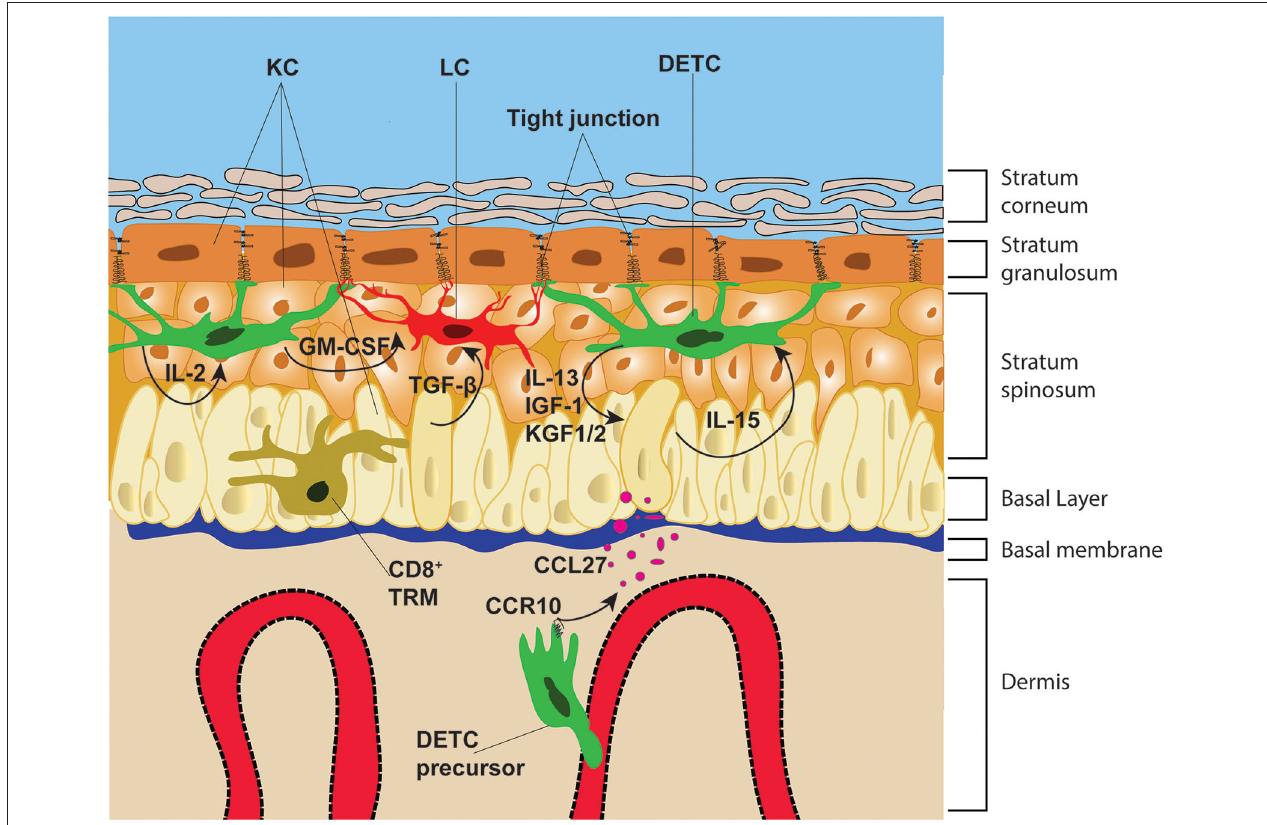
FIGURE 1 | Epithelial architecture and immune cell distribution. The epidermis is divided from the dermis by the basal membrane. The epidermis is composed of four distinct layers: the stratum corneum, stratum granulosum, stratum spinosum and basal layer. These layers are composed mainly of KC that are infiltrated with immune cells, such as DETC, LC, and CD8 + TRM. DETC precursors in neonatal mice, home to the epidermis via the blood vessels and following the chemotactic gradient of KC-derived CCL27. DETC and LC form stable interactions with KC tight junctions, whereas CD8 + TRM migrate along the basal layer and in-between KC. DETC produce multiple soluble factors that promote KC survival and proliferation and receive IL-15 from KC, which promotes their lifelong survival and